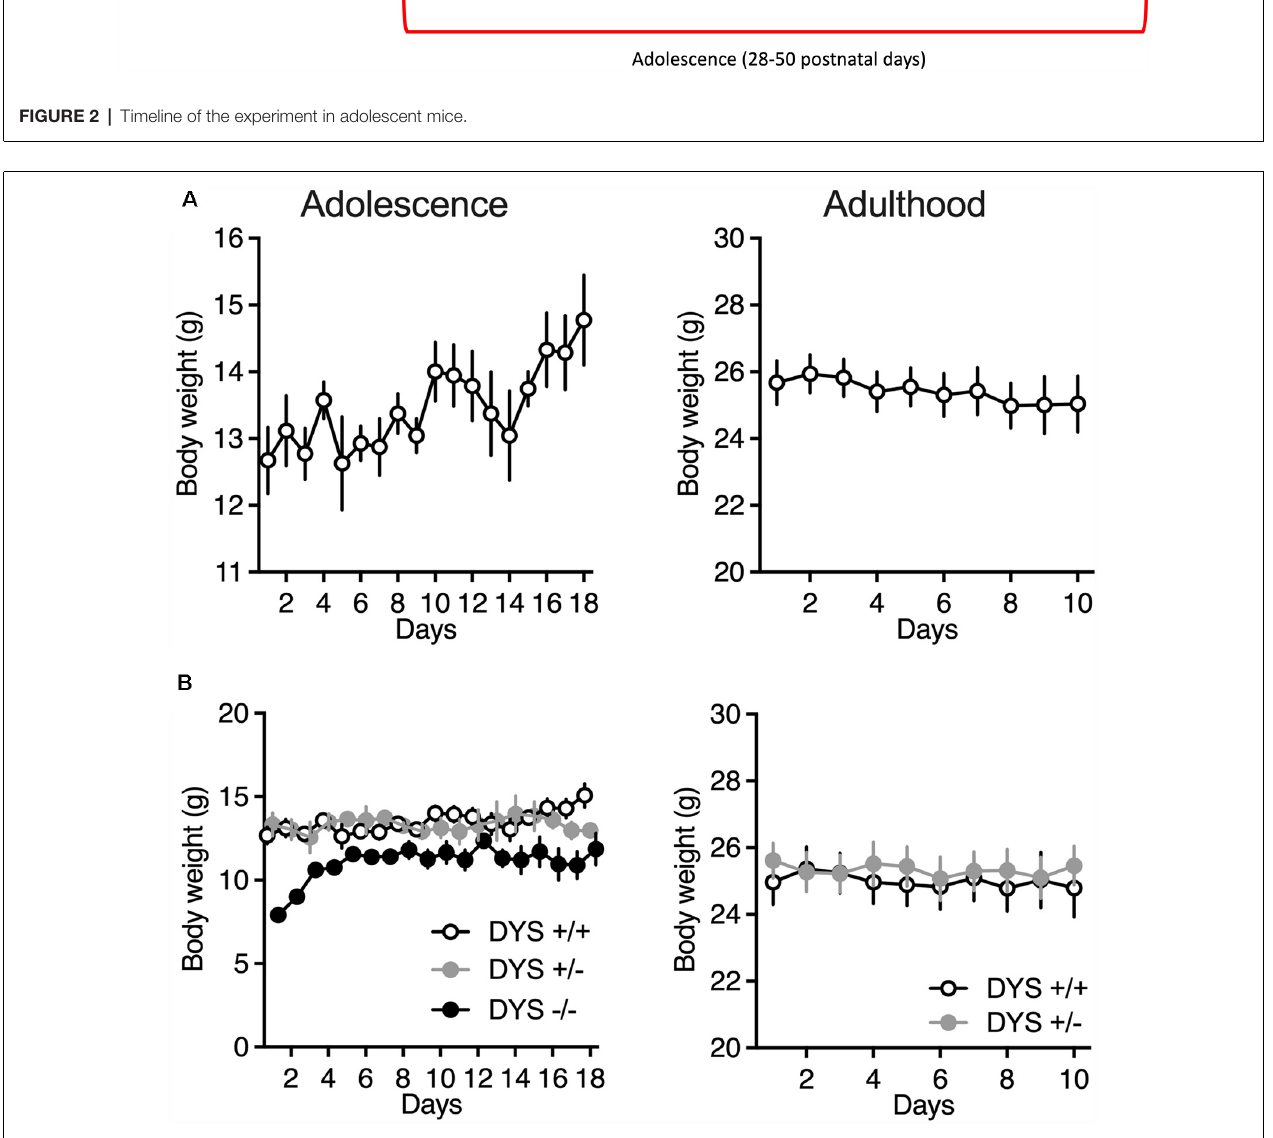
FIGURE 3 | (A) Body weight of adolescent and adult wild-type mice during the ID/ED Operon task. (B) Body weight of adolescent DYS + / + , DYS + / − , and DYS − / − mice during the ID/ED Operon task. Values represent mean ± SEM. Abbreviations: ID, intra-dimensional set-shift task; ED, extra-dimensional set-shift